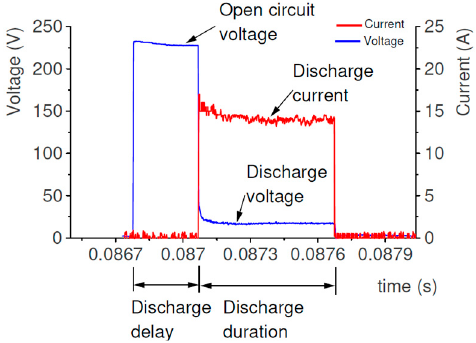
Figure 2. The registered waveform of discharge current and voltage.